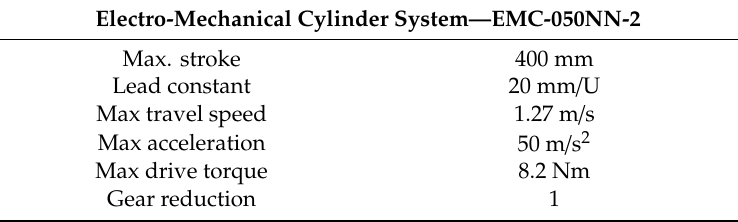
Figure 1. Mechanical design of the platform. Details A and B show the cardan joints that attached each leg with the two platforms. Detail C shows the amplified load cell mounted on each leg. Each leg is actuated by a linear actuator (Rexroth Bosh group, Lohr a. Main, Germany). The features of the motors we adopted are summarized in Table 1. Table 1. Main features of the